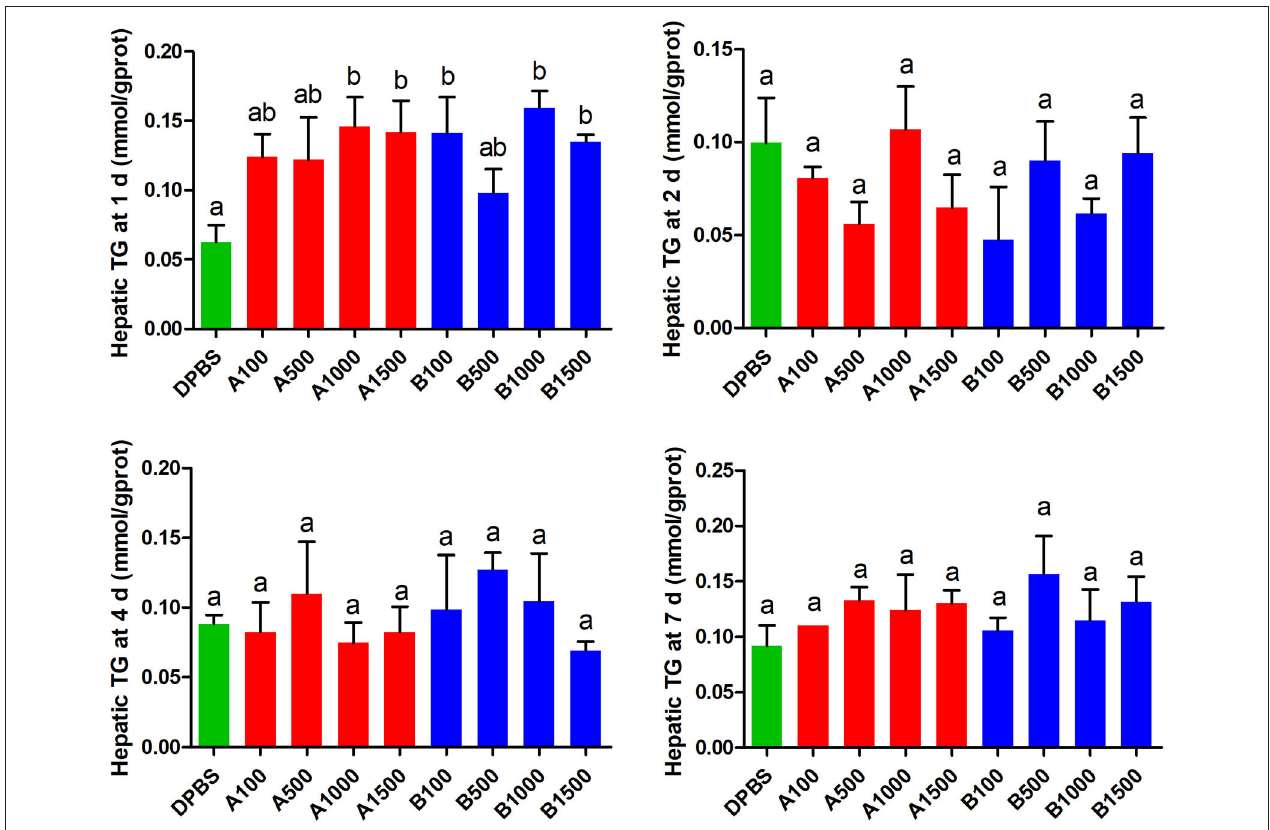
FIGURE 5 | The effects of intraperitoneal injection of leptin A and leptin B on hepatic TG levels at 1, 2, 4, and 7 d. Data represent means ± S.E.M ( n = 6). The colors of bars were shaded according to intraperitoneal injection of different solvent (green: DPBS, red: LepA, blue: Lep B). Significance level are marked with different letters ( P < 0.05), compared with the values from DPBS injected mandarin